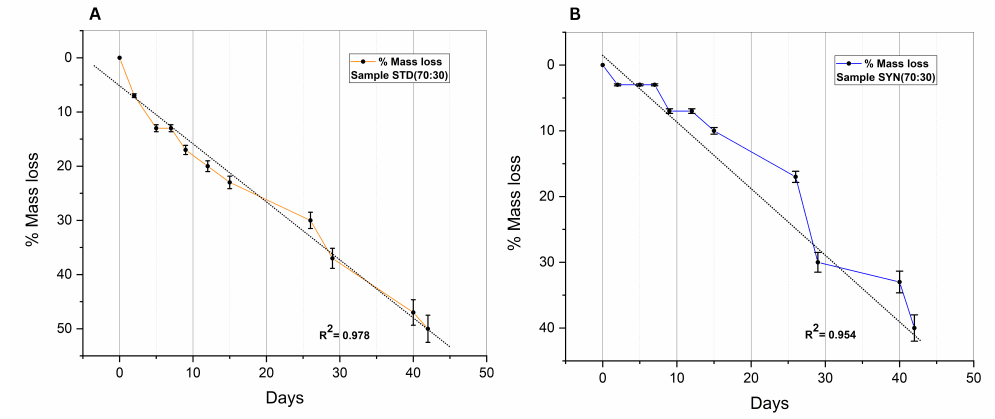
Figure 10. Degradation curves of samples: ( A ) STD (70:30); ( B ) SYN